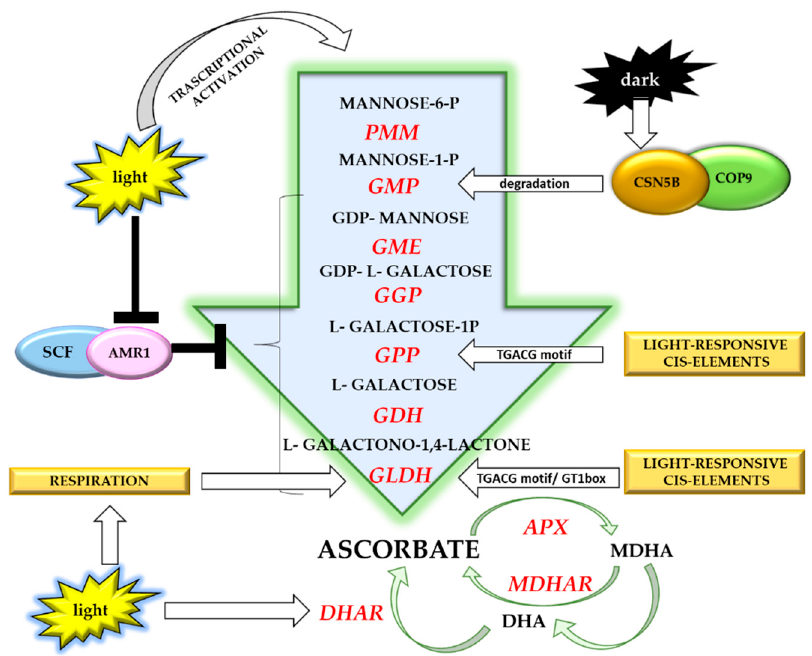
Figure 3. Light-dependent mechanisms involved in vitamin C accumulation (details are provided in the